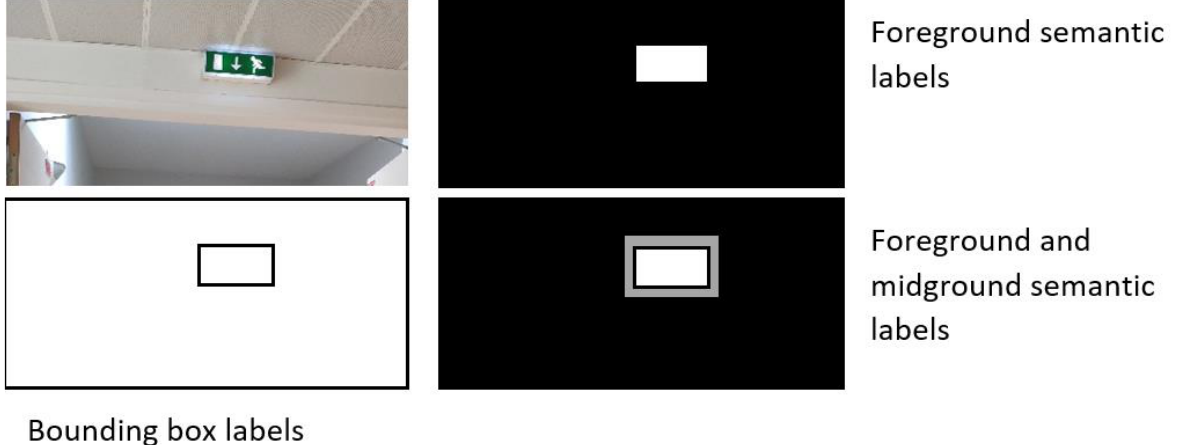
Figure 3. Semantic label generation.